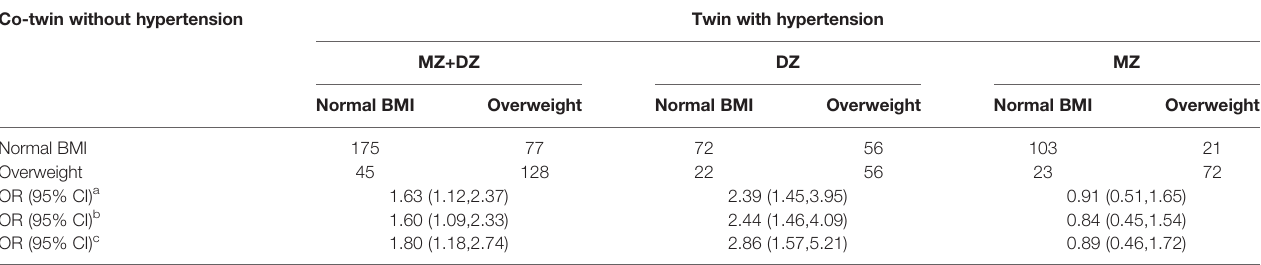
TABLE 3 | ORs (95% CIs) for the association between overweight or obesity and hypertension in co-twin control analyses using hypertension discordant twin pairs from the conditional logistic regressions. Co-twin without